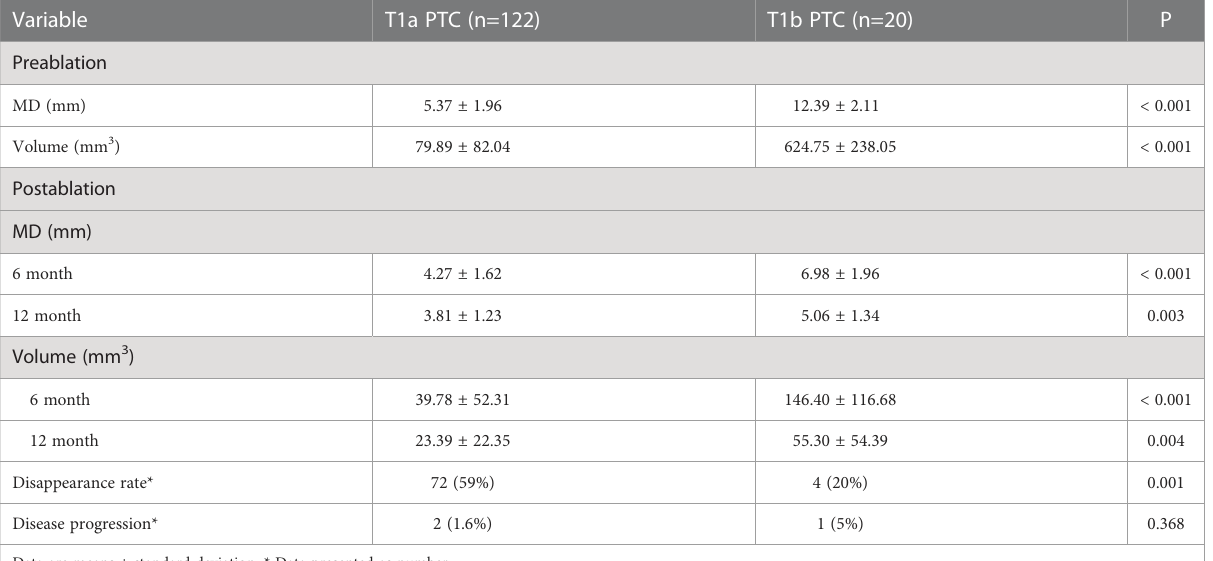
TABLE 3 The comparison of T1a and T1b